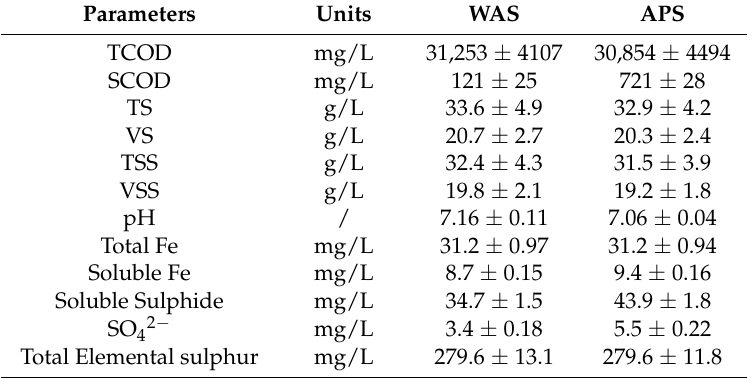
Table 1. The Characteristics of WAS and APS. WAS: waste-activated sludge; APS: alkaline-pretreated sludge; TCOD: total chemical oxygen demand; SCOD; soluble chemical oxygen demand; TS; total solids; VS: volatile solids; TSS: total suspended solids; and VSS: volatile suspended solids. Parameters Units